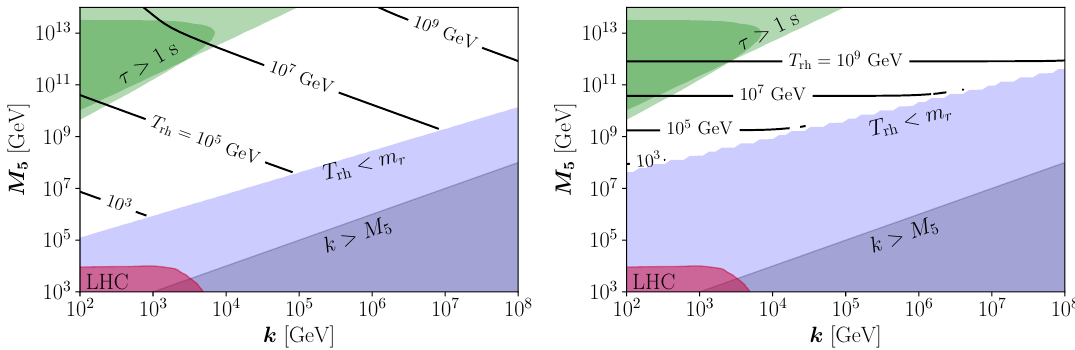
Figure 4 . Sequential freeze-in via annihilations (left panel) and via inverse decays (right panel): contours for the reheating temperature required to reproduce the observed DM abundance, for m DM = 1 MeV. The red-shaded region is in tension with LHC Run-II results from refs. [4, 62]. The dark blue-shaded region for which k > M 5 is beyond the EFT approach. The green-shaded region corresponds to lifetimes of KK-modes longer than 1 s. Eventually, the light blue-shaded region depicts the region of the parameter space for which T rh < m v 1